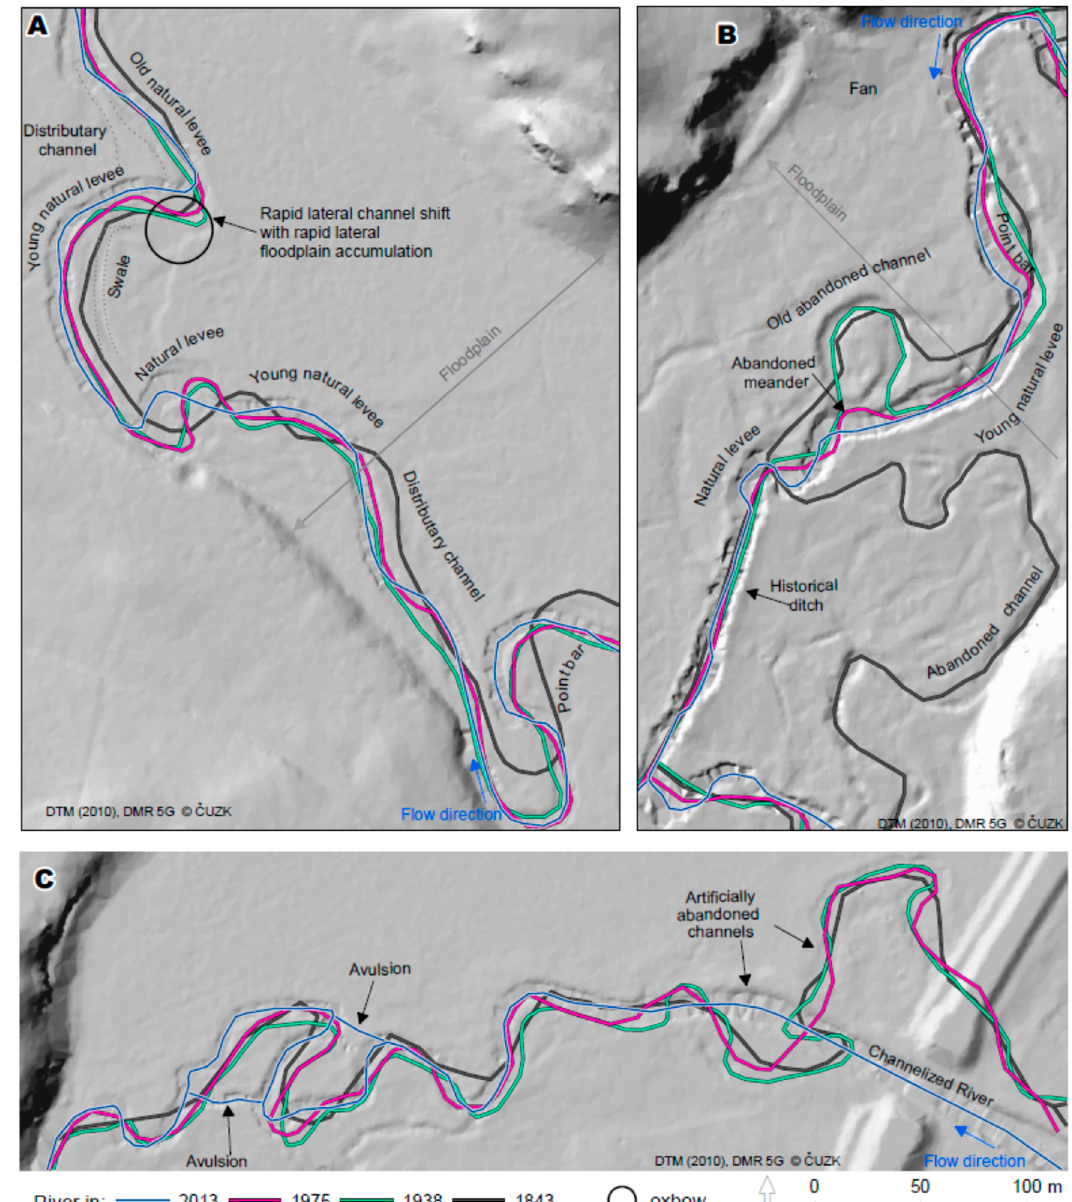
Figure 5. Historical channel positions and interpreted geomorphologic features in the study areas: ( A ) MS-West of Hrad č any, ( B ) AT1-Hrad č any, and ( C ) MH-Bore č ek.